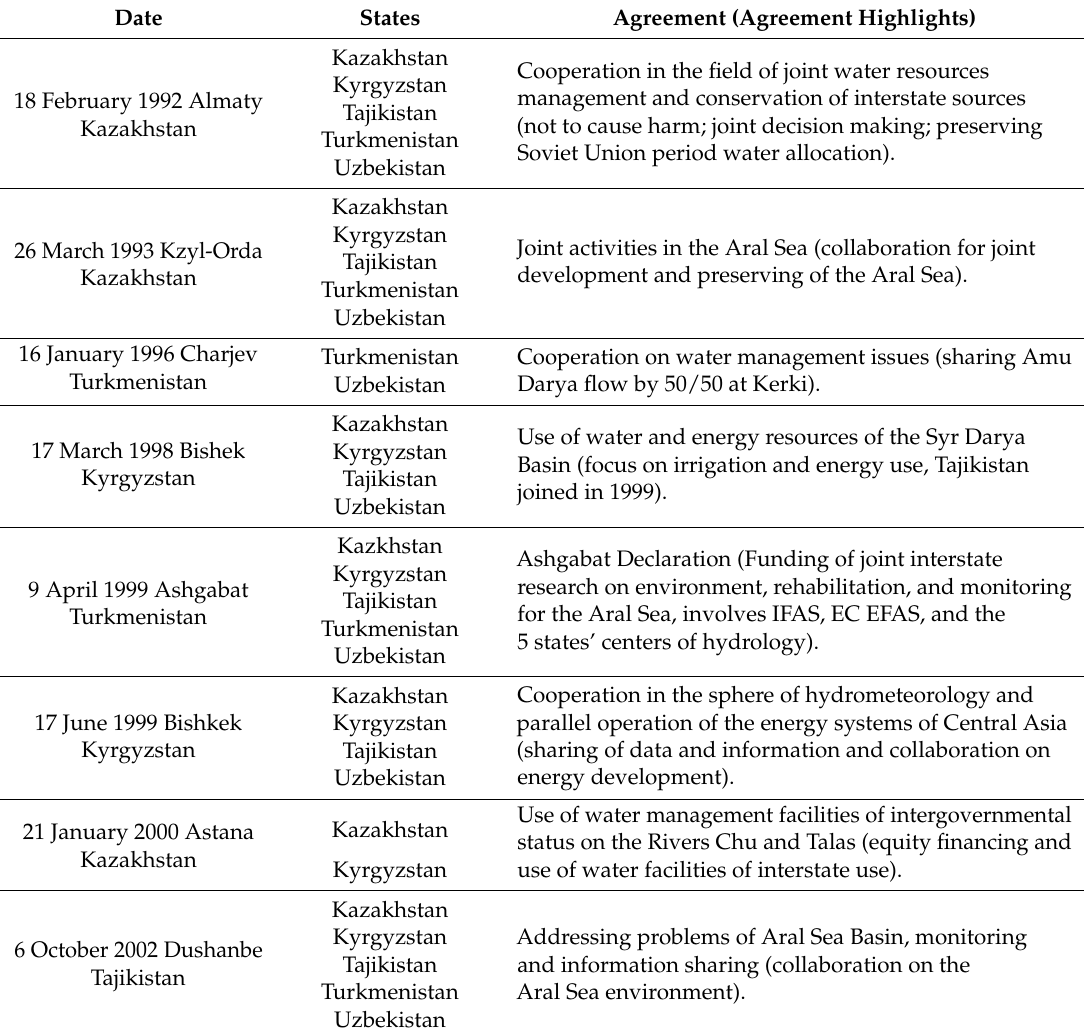
Table 3. Select water related agreements within Central Asia (after Volovik [68] and Soliev et al.